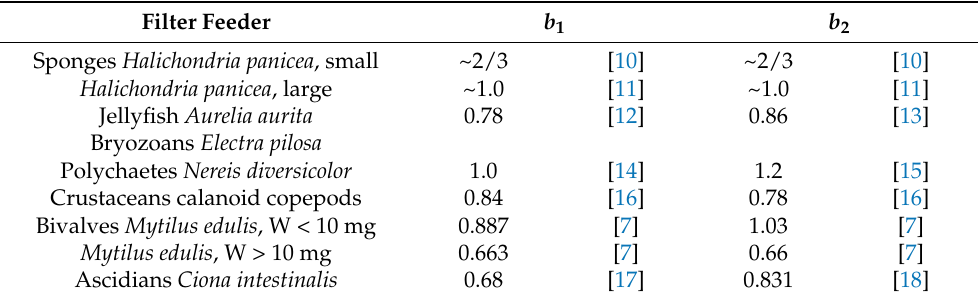
Table 1. b -exponents of rates of filtration b 1 (in F = a 1 W b1 ) and respiration b 2 (in R = a 2 W b2 ) of some filter-feeding invertebrates. Halichondria panicea, “small” = single osculum sponge explant; “large” = multi-oscula sponge.